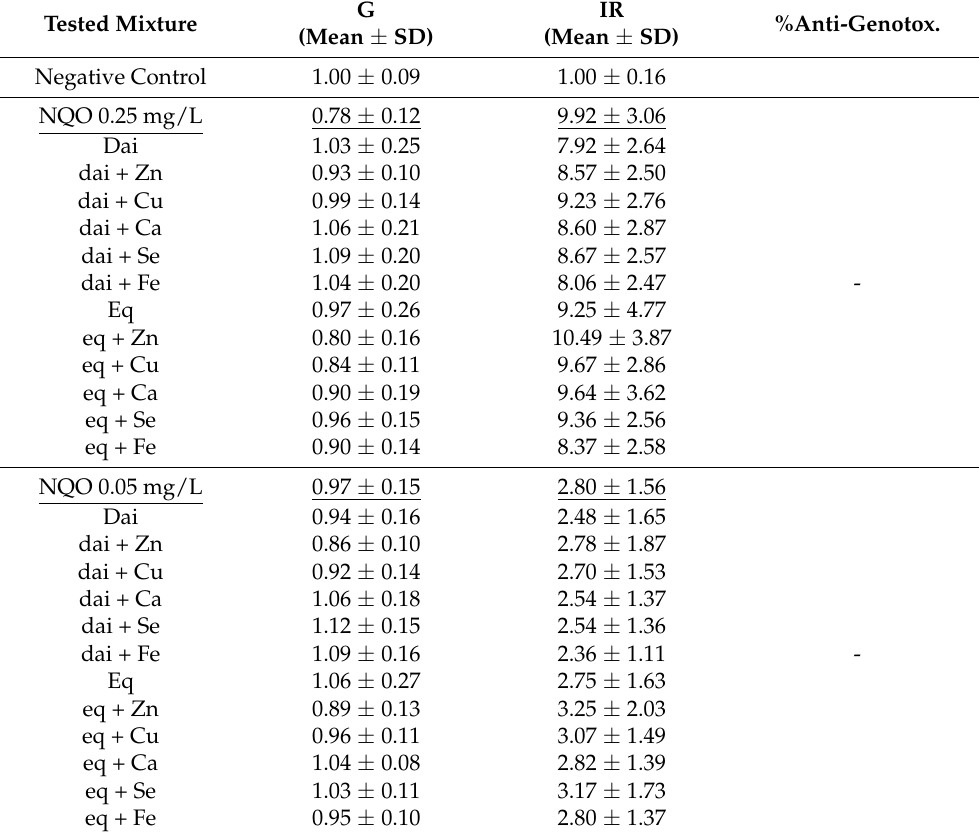
Table 3. Evaluation of anti-genotoxic activity based on G and IR values for the genotoxin—4NQO (0.25 mg/L, 0.05 mg/L)—and the mixture of NQO with daidzein, equol and the combinations with